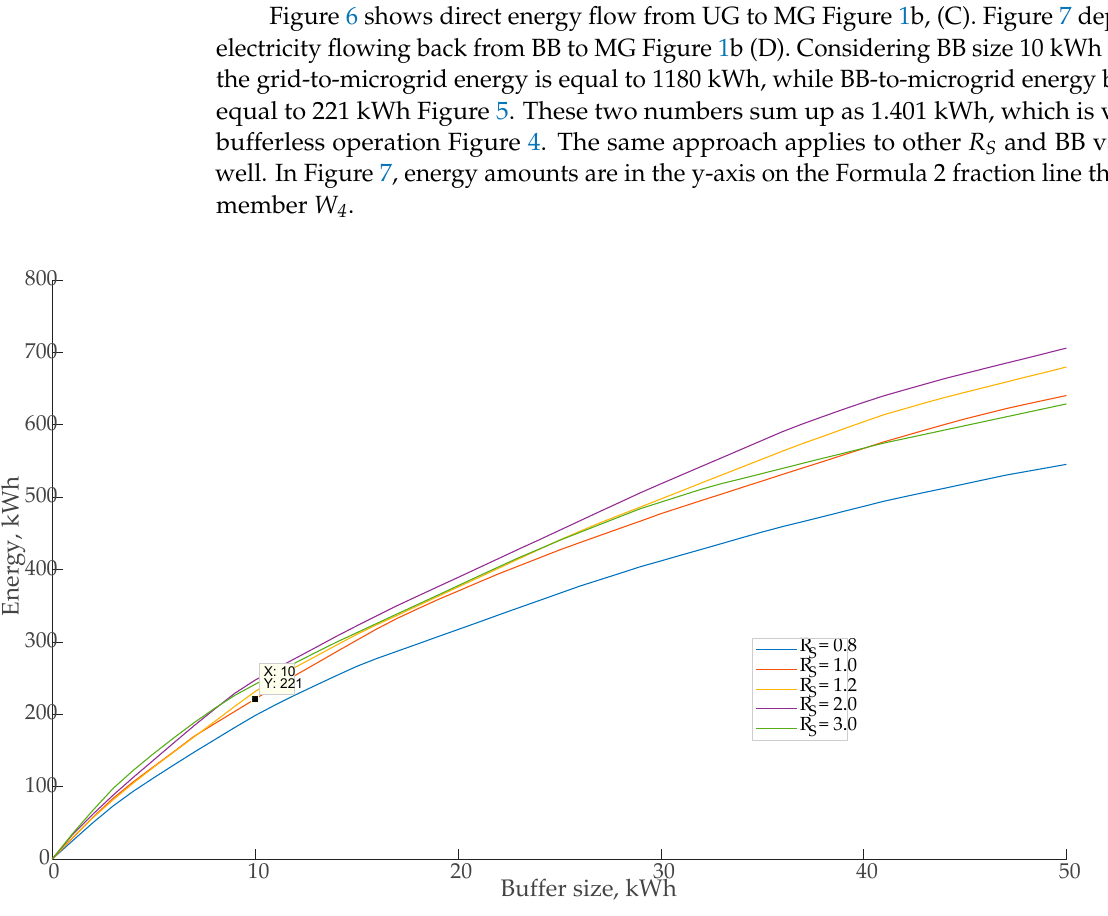
Figure 7. Energy from buffer battery (BB) to microgrid (MG).